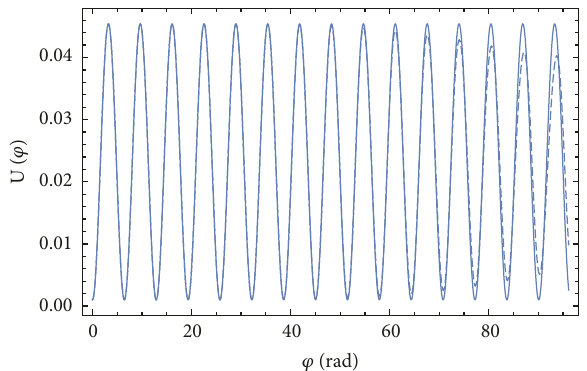
Figure 1: Comparison of the numerical solution 𝑈(𝜑) of (80) (solid curve) and of the truncated power series solution obtained by the Laplace-Adomian Decomposition Method, given by (105) (dashed curve), for 𝑏 2 = 0.0225 and 𝑎 = 0.001 .